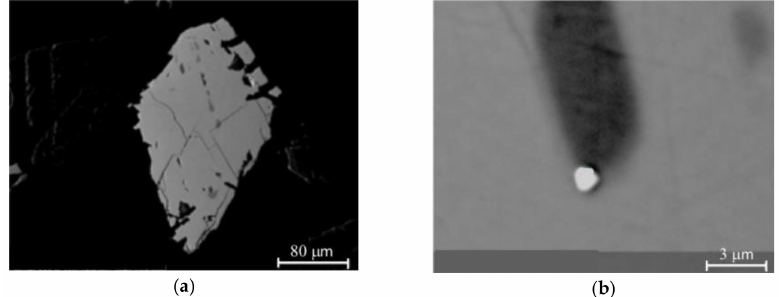
Figure 3. Sample A1F-SM: BSE image (EPMA). Sphalerite with inclusion of electrum and chalcopyrite ( a ) and BSE image (EPMA) of the magnification of the electrum inclusion ( b